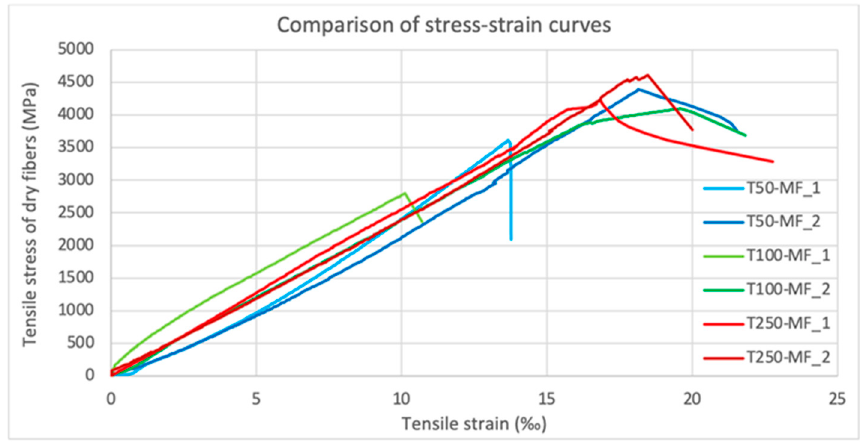
Figure 11. Stress–strain curves of monotonic, uniaxial tensile tests after exposure to the temperatures of 50, 100 and 250 °C and then cooling.